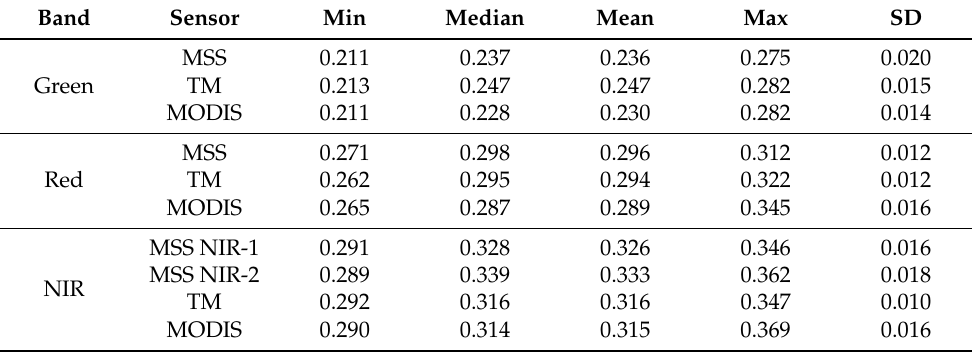
Table 8. Statistics of time-series reflectance of MSS, TM, and MODIS in ROI 2 (ROI 2: